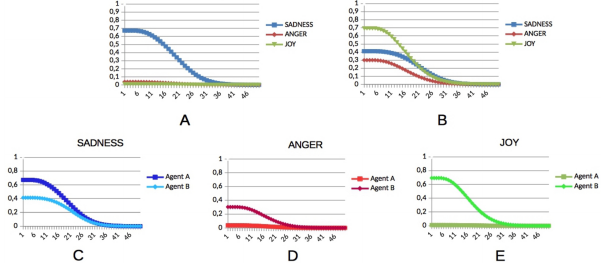
Fig. 4. Simulation results for pure amplification scenario set to downwards tendency simulating three emotions BLUE , RED and GREEN : A) emotional dynamic of agent A , B) emotional dynamic of agent B , C) emotional evolution of SADNESS on agents A and B , D) emotional dynamic of ANGER on agents A and B , and E) emotional dynamic of emotion JOY on agents A and B . The horizontal axis denotes time elapsing in number of iterations and the vertical axis denotes emotional level in all graphics. Notice how emotions tend to decay in time reaching its minimum no matter how high they have been initialized.